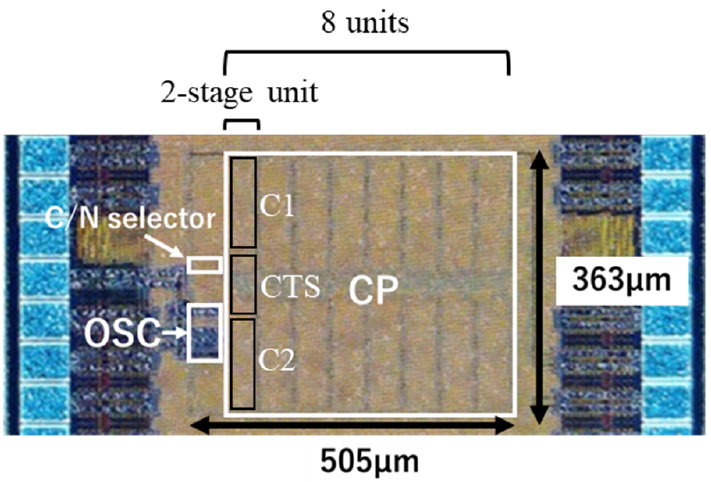
Figure 14. Die photo.